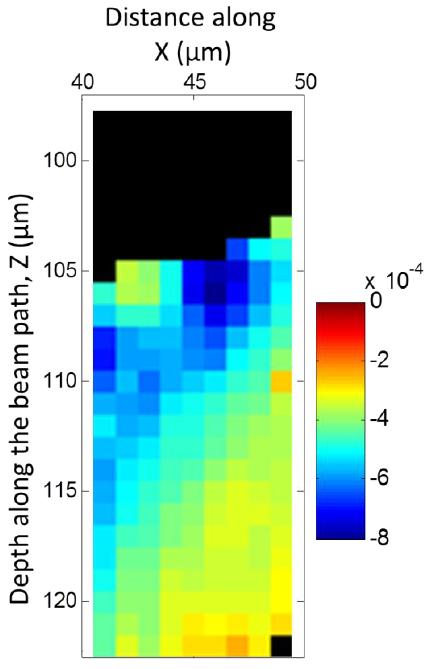
Figure 5. Elastic strain as a function of distance from the nodule/matrix interface for the region marked by the white box in Figure 4. Black part is the graphite nodule. This figure is modified from Figure 6 in [38].